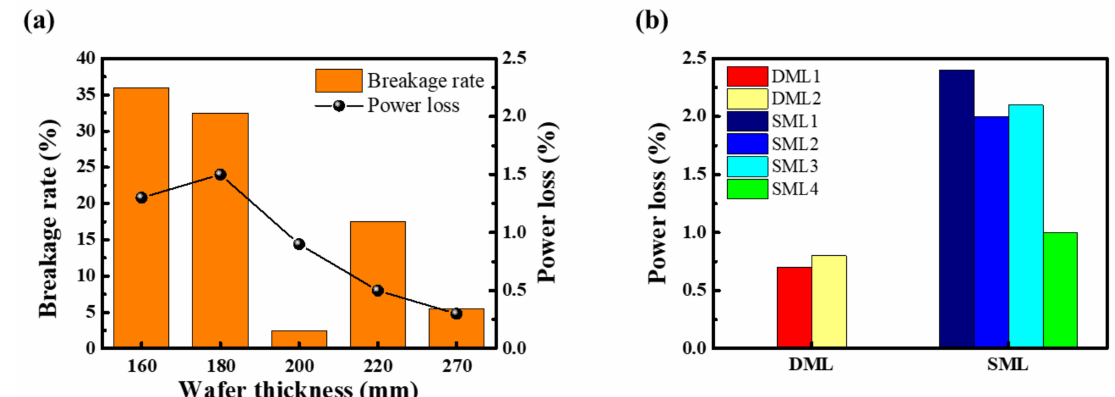
Figure 16. Degradation rate of a PV module with ( a ) breakage rate and power loss according to thickness after DML tests and ( b ) comparison of power loss between DML and SML